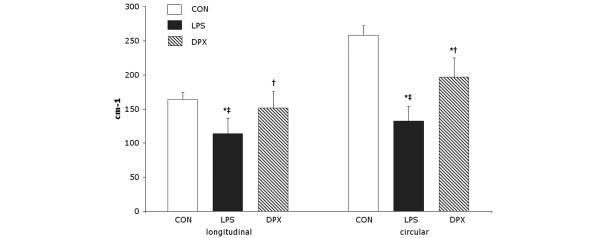
Functional capillary density. Shown is functional capillary density (FCD) in the longitudinal and circular muscularis layers; measurements were taken at two hours after the start of endotoxaemia. CON, control group; DPX, DPX group (endotoxin plus dopexamine); LPS, LPS group (endotoxin infusion only). *P < 0.05 versus CON; †P < 0.05 versus LPS; ‡P < 0.05 versus DPX.